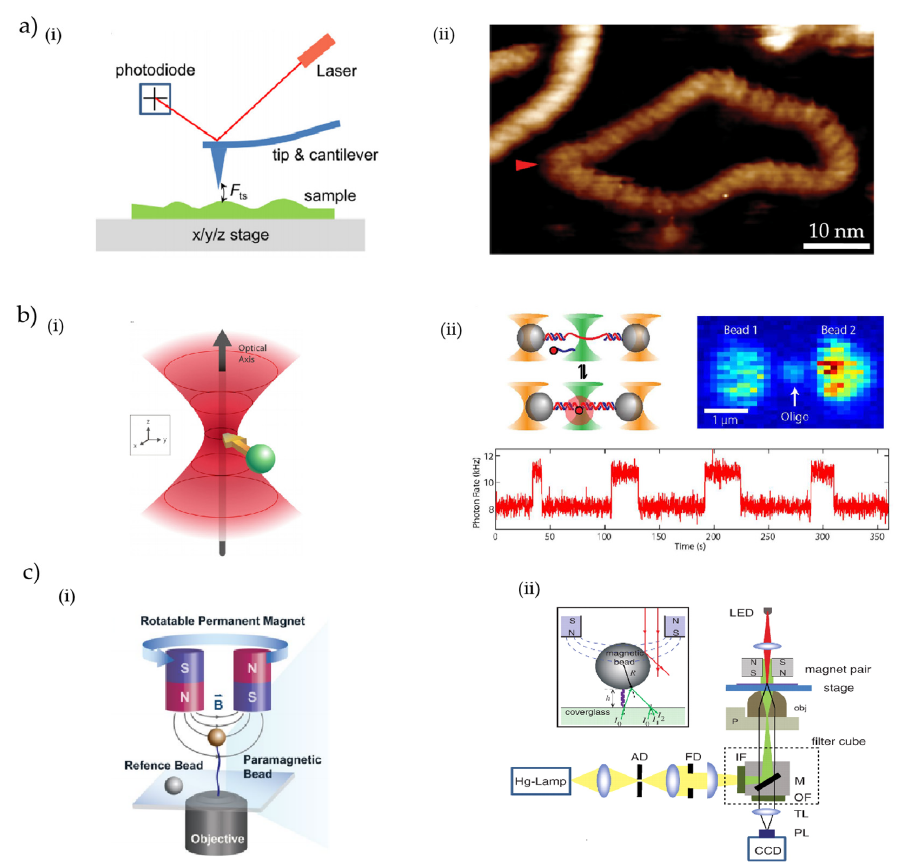
Figure 3. ( a ) ( i ) Basic working principle of AFM. Schematic of typical AFM. The tip-sample force Fts induces a deflection of the cantilever, which is detected by recording the position of the reflected laser beam with a position-sensitive photodiode [150]. ( ii ) High-resolution AFM images of natively supercoiled DNA minicircles [159]. ( b ) ( i ) Schematic representation of the principle of optical tweezer [190]. ( ii ) Combined high-resolution optical tweezers and confocal microscope. Dual optical traps (outer cones) hold polystyrene microspheres (spheres) tethered by a DNA construct (here a DNA hairpin), while a confocal microscope (middle cone) detects fluorescence from a single molecule [199]. ( c ) ( i ) Illustration of the magnetic tweezers setup [211]. ( ii ) Experimental setup for bio-